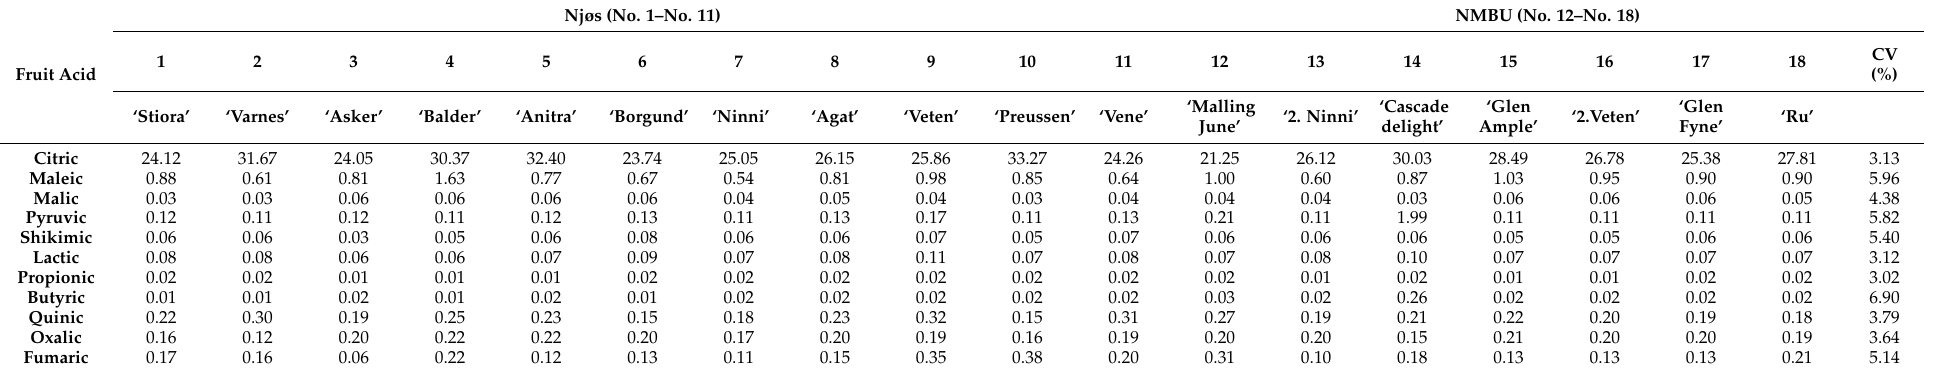
Table 2. The averages of the values of the contents of fruit acids (g/kg) in 18 raspberry extract samples during the two-year collection from two Norwegian regions